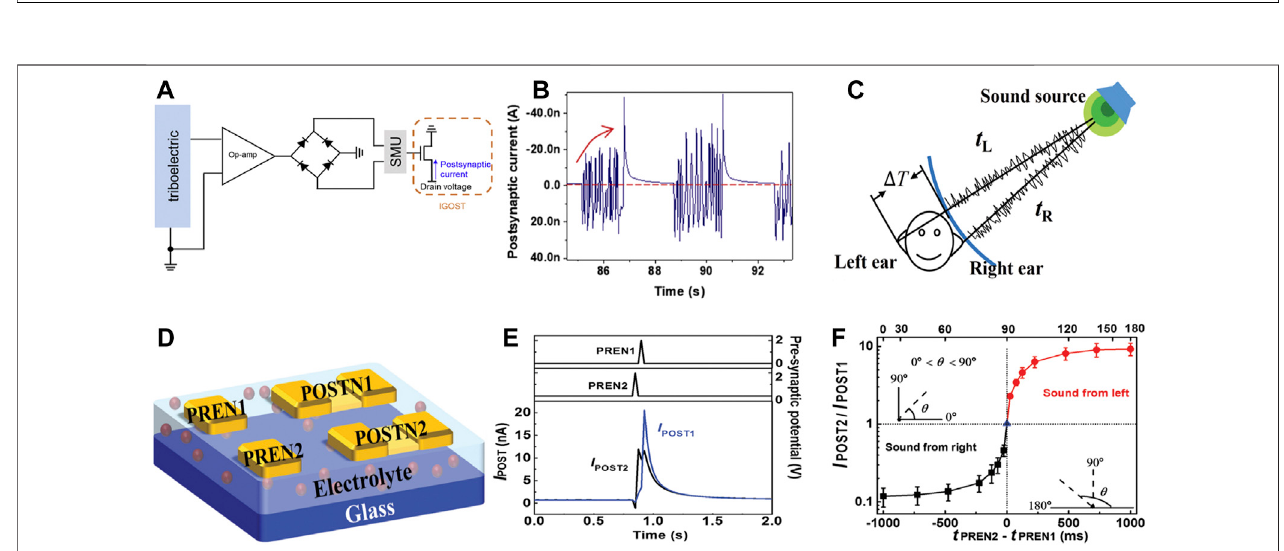
FIGURE9|(A) Circuit diagram oftheauditory nervoussystem.Triboelectric devicedetectssonicconnectionIGOST. Anoperationalampli fi er ampli fi esthevoltage from the triboelectric device. The recti fi er converts the bidirectional output signal to a unidirectional output. (B) Membranes prepared at 80 ° C measured postsynaptic currents of IGOST (adapted from Seo et al., 2019). (C) Schematic diagram of binaural effect localizing sound in the human brain. (D) Schematic diagram of the sound localization of the prepared arti fi cial neural network. (E) Postsynaptic currents of POSTN1 and POSTN2 when sound comes in the correct direction. (F) Change of I POST2 /I POST1 with time interval, sound azimuth (adapted from He et al., 2019).